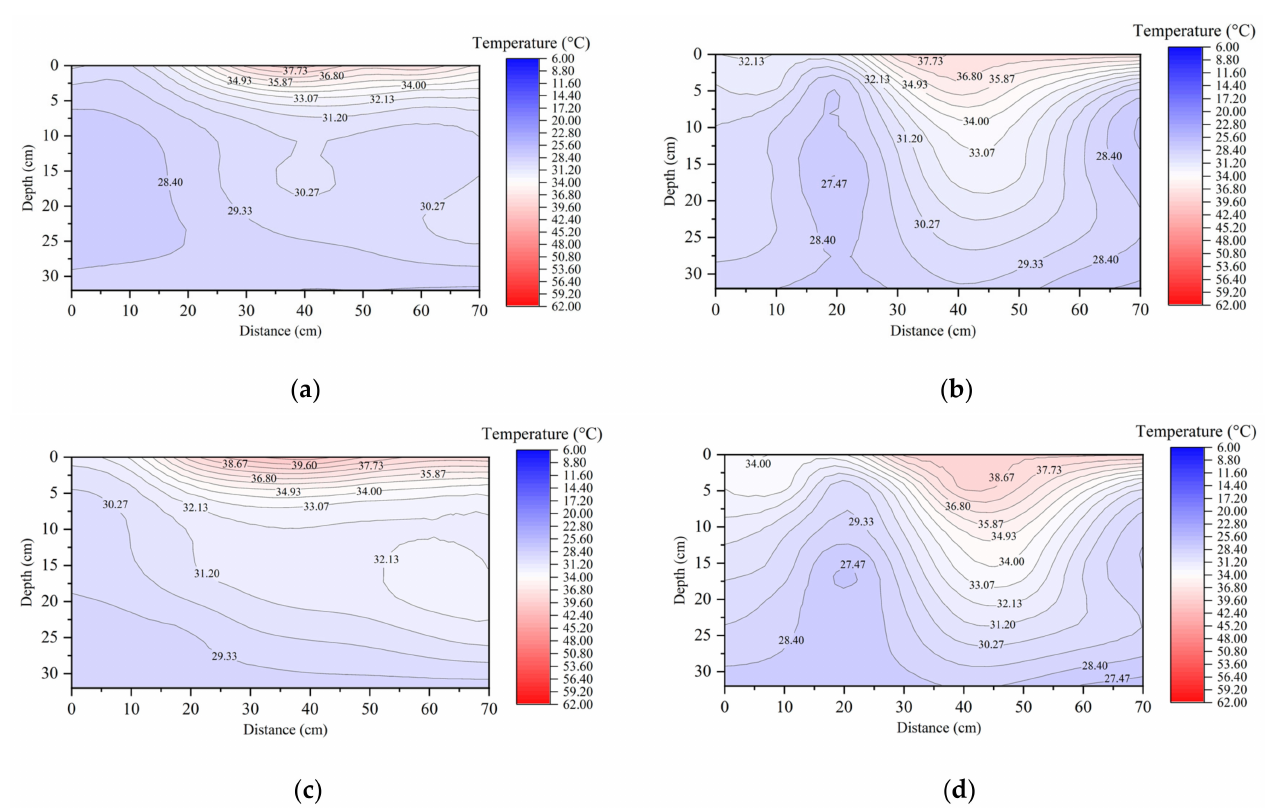
Figure 11. The 2D distribution diagram of average soil temperatures for the entire period: ( a ) Mea- sured distribution under W1; ( b ) simulated distribution under W1; ( c ) measured distribution under W2; ( d ) simulated distribution under W2.